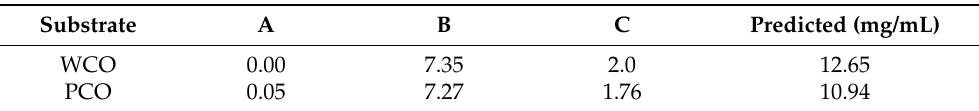
Table 2. Experimental design for the validation of biosurfactant production by BS14 bacterial